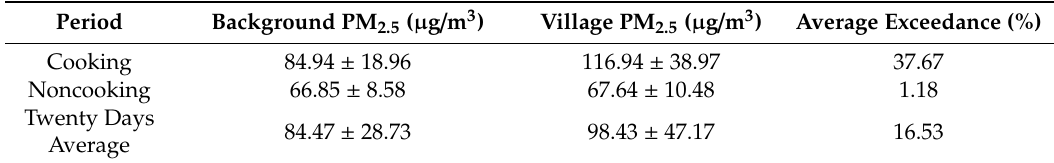
Figure 6. ( a ) Plot showing diurnal variation of PM 2.5 concentration (µg/m 3 ) for background (blue line) and semi-rural site (black line). The light blue shade and light gray shade represent the 25th and 75th percentiles of background and semi-rural sites concentration respectively. ( b ) Scatter plot between semi-rural sites and background level concentration during both cooking and non-cooking hours. Blue dots represent the non-cooking hour and red dots represent the cooking hours with linear fit, with blue and red line respectively for non-cooking and cooking hours. Table 3. Comparison of PM 2.5 level between village and background location in various